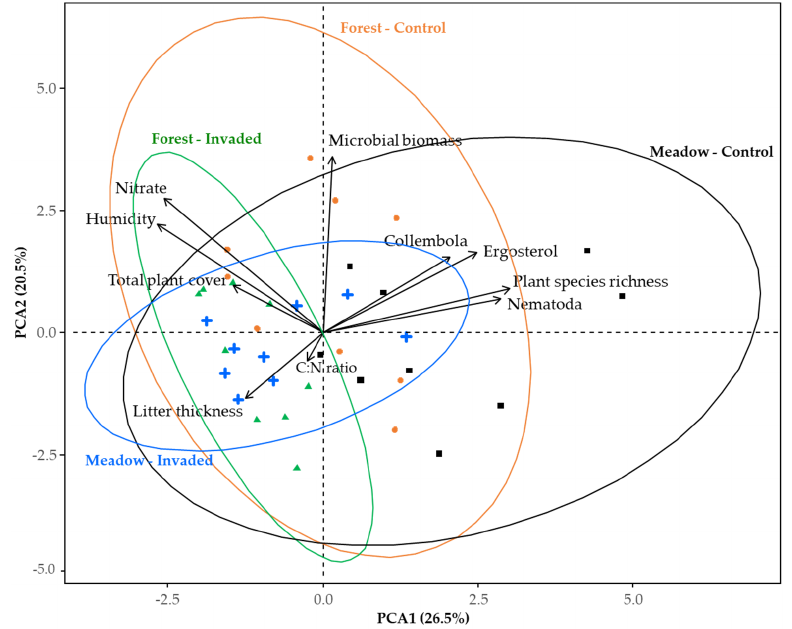
Figure 3. Principal component analysis (PCA) ordination of 10 variables (C:N ratio, nitrate, microbial biomass, ergosterol, relative soil humidity, litter thickness, plant species richness, total plant cover, total Collembola and total Nematoda abundances) based on the 36 quadrats of control forest (orange circle), invaded forest (green triangle), control meadow (black square) and invaded meadow (blue cross). Samples from each treatment ( n = 9) are grouped within ellipses. Variables are represented by arrows.